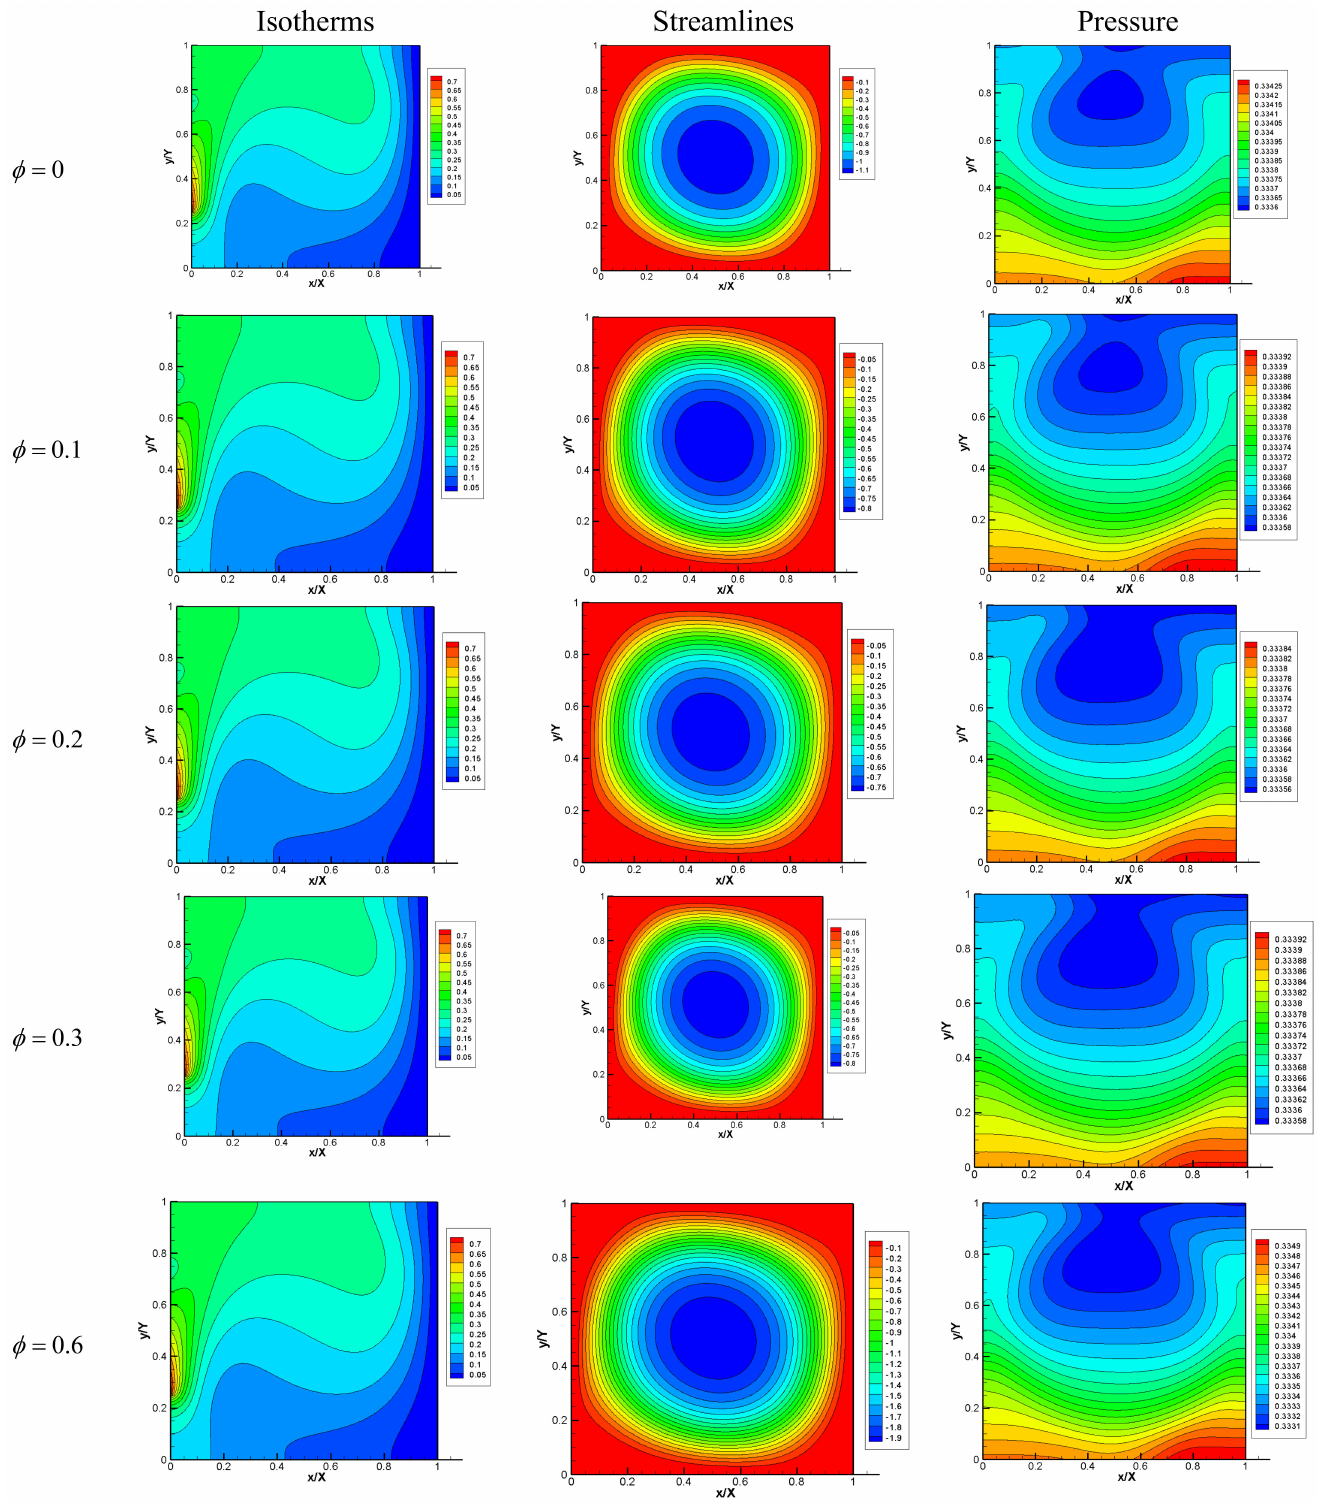
Figure 12. Steady state non-dimensional isotherm, streamline, and pressure profile behavior for central partially left boundary conditions (case 2: linear boundary condition) at different volume fractions ( φ ) for Ra = 10 5